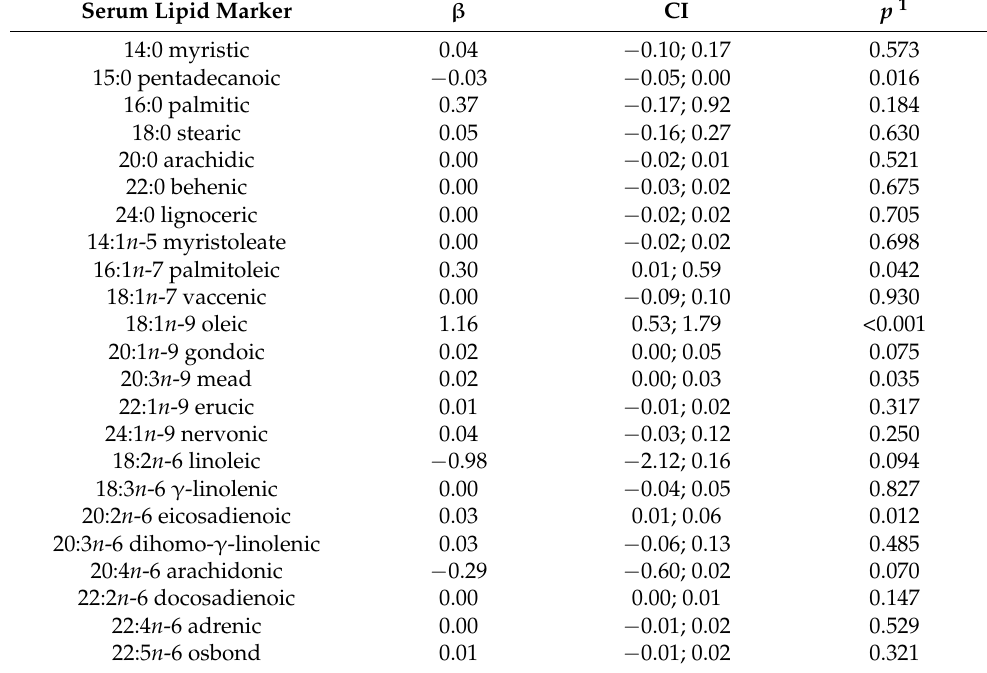
Table 4. Association of serum fatty acids, plasmalogens metabolites and estimated desaturases with the presence of retinal microangiopathy (MA) in full-adjusted